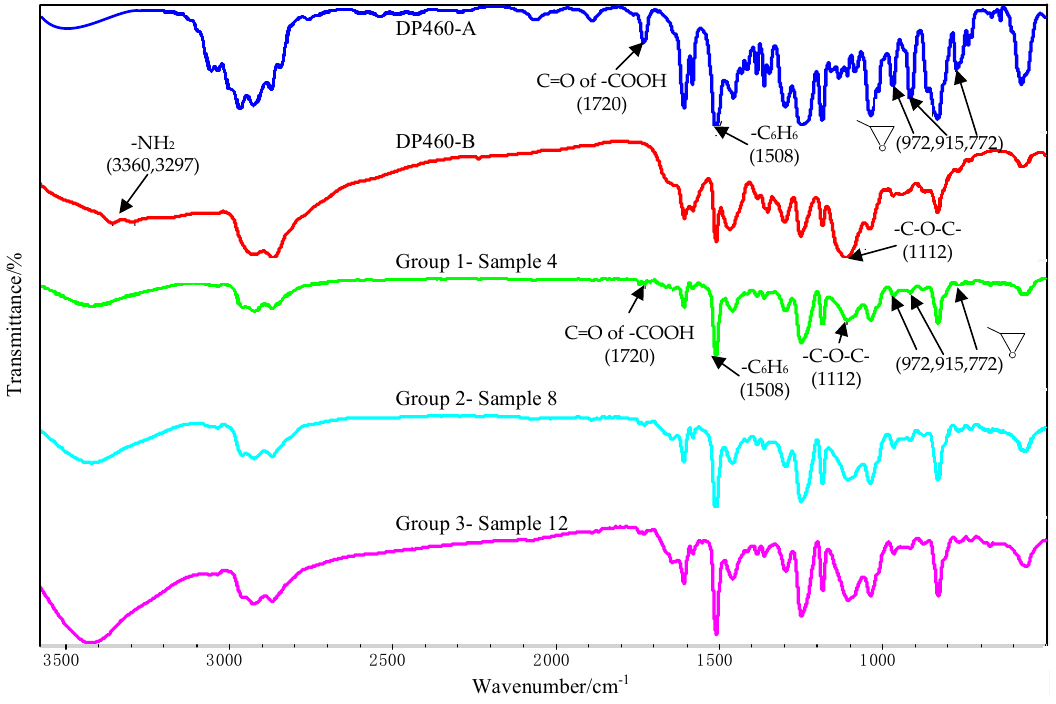
Figure 13. FTIR spectra of DP460-A / DP460-B and the interface between the Al alloy sheet and the adhesive.